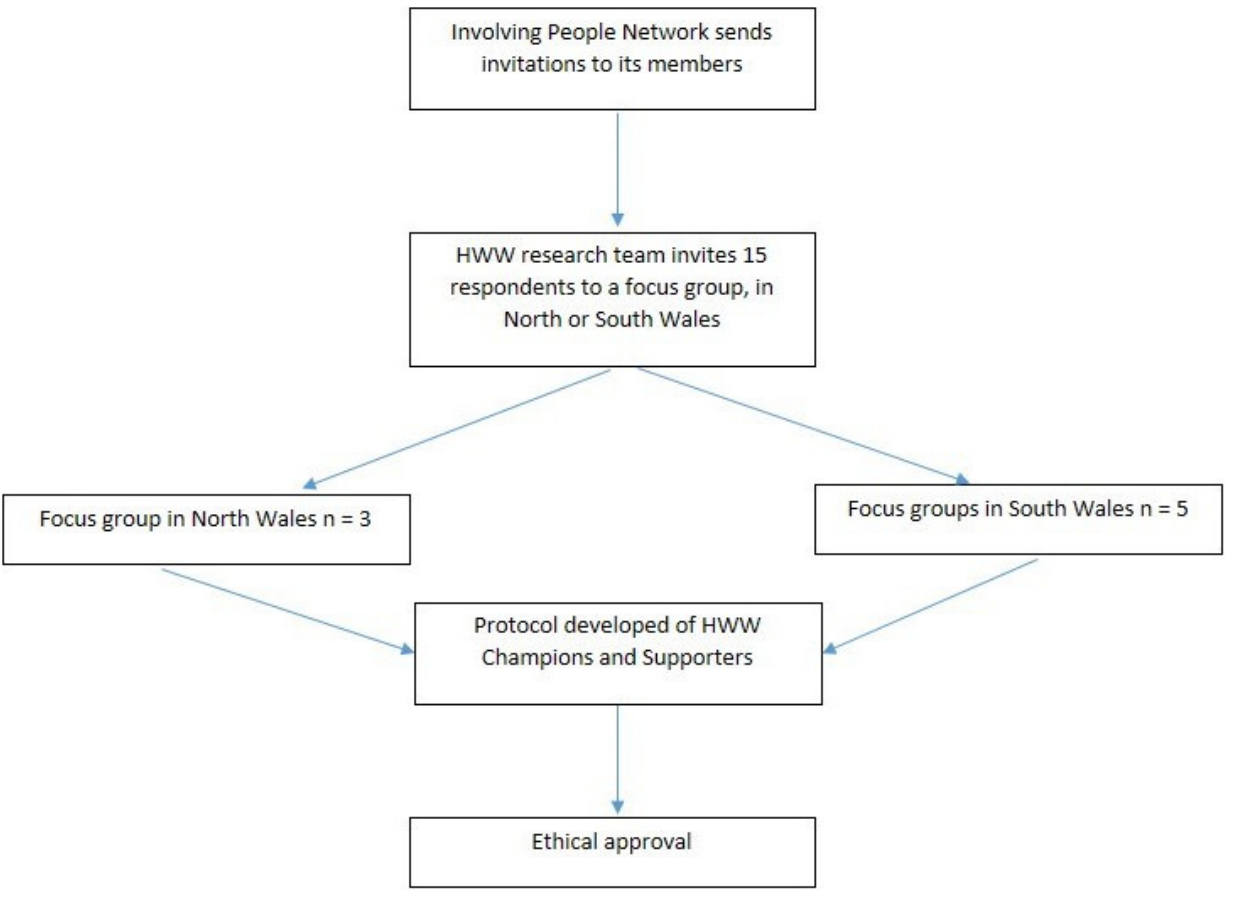
Figure 1: Flow chart illustrating the methods used to develop the